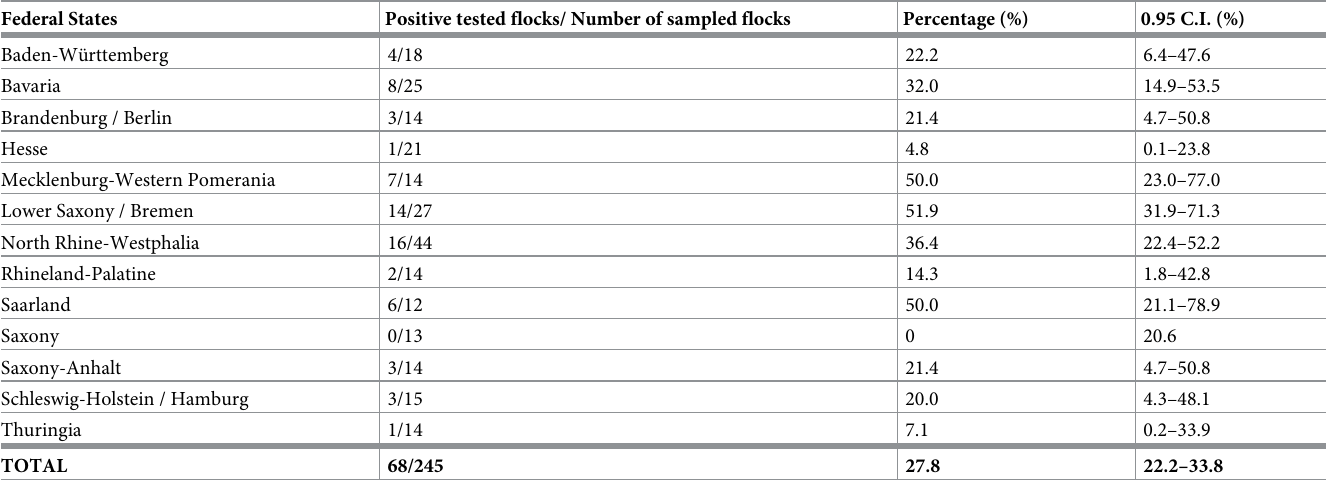
Upland, Scarplands on either sides of the Rhine Valley, and the Alpine Forland (Fig 2). Table 3. Prevalence of S . calchasi in different federal